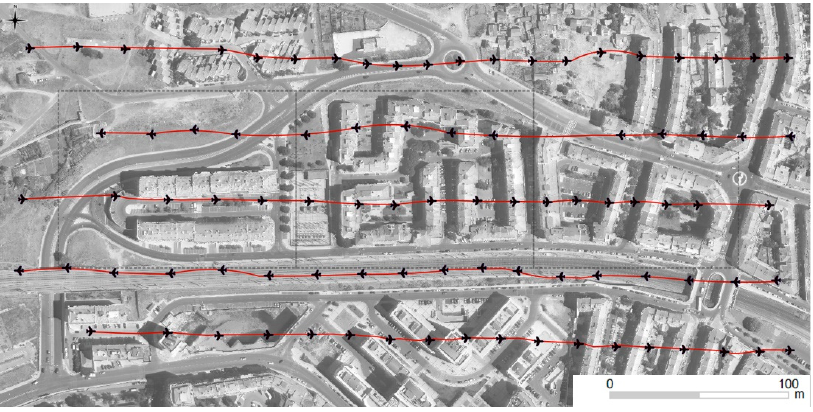
Figure 3. Trajectory flight lines performed by Swinglet CAM.